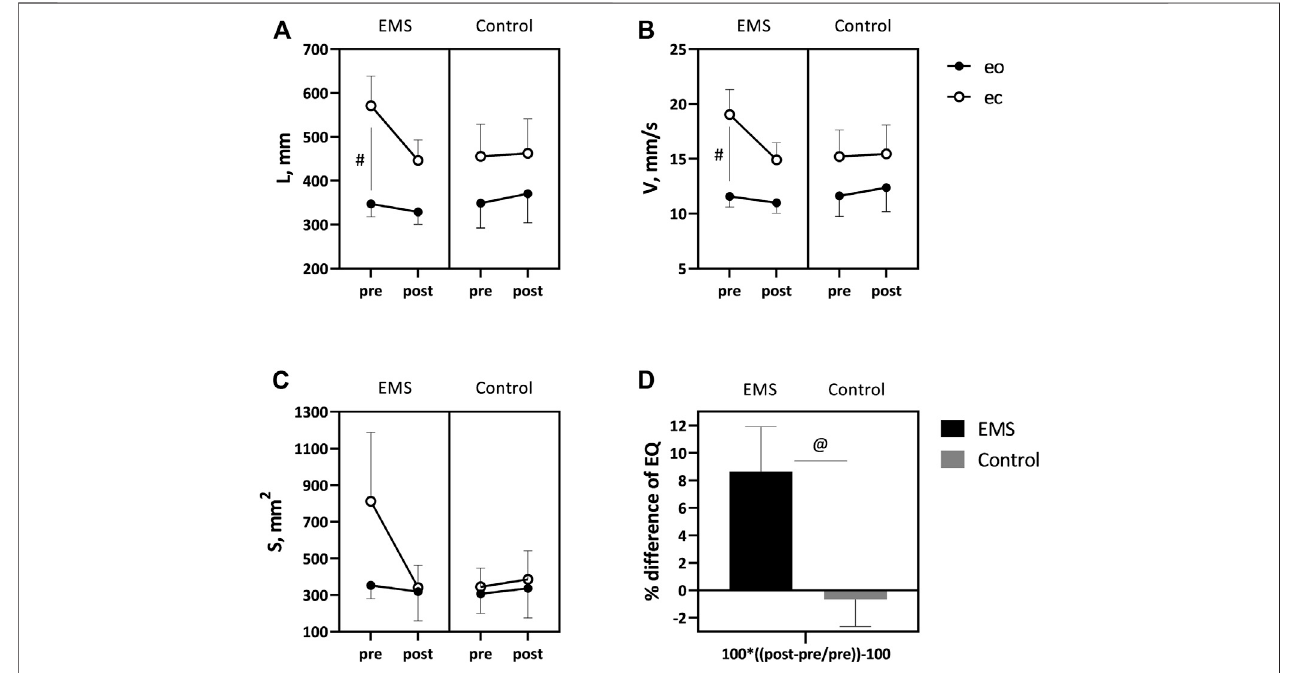
FIGURE 3 | Comparative data for length (A) and velocity (B) of the CoP and area of the statokinesiogram (C) in eyes open (shaded icons) and closed (not shaded icons), and also change in EQ (D) in the two patient groups. Mean ± SEM. # − p < 0.05 eyes open vs. eyes closed.at − p < 0.05 EMS vs. control.